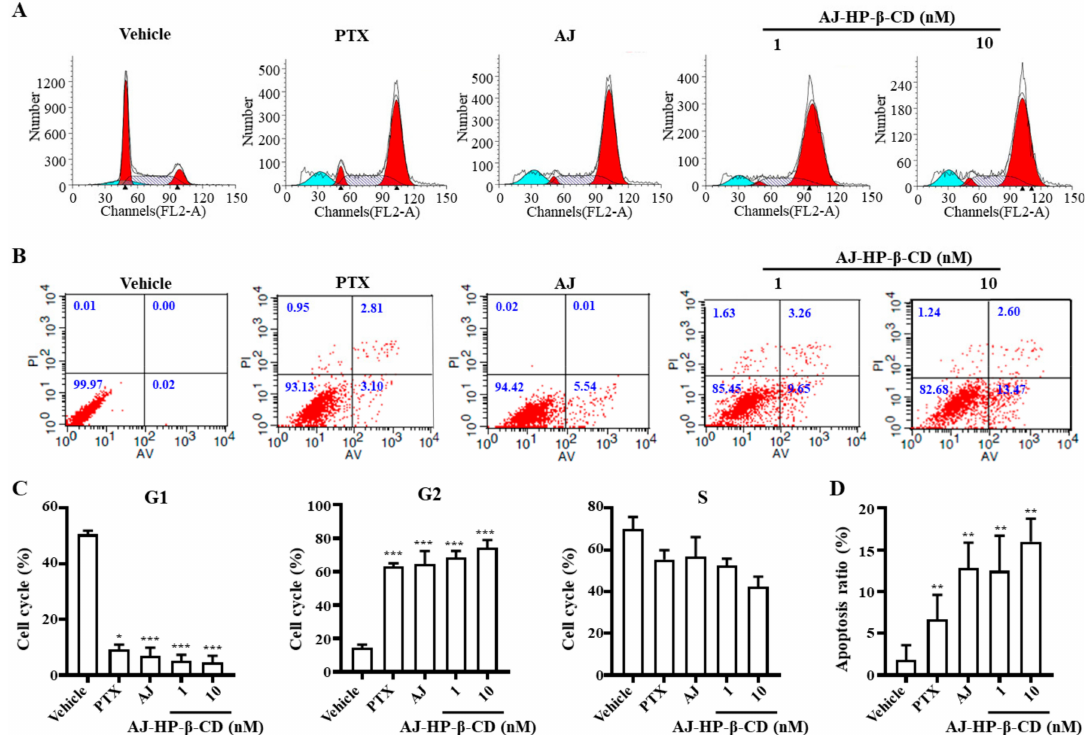
Figure 5. E ff ect of AJ-HP- β -CD on the cell cycle and apoptosis in 786-O cells. ( A ) 786-O cells were treated with PTX (10 nM), AJ (10 nM), and AJ-HP- β -CD (1, 3, 10 nM) for 12 h, and a flow cytometry analysis of the cell cycle assay was performed. ( B ) 786-O cells were treated with PTX (10 nM), AJ (10 nM), and AJ-HP- β -CD (1, 3, 10 nM) for 24 h. A flow cytometry analysis of apoptosis was performed in each group of cells. ( C ) The percentage of cells in G1, G2, S phases are shown in the histogram. ( D ) The percentage of apoptotic cells are quantitatively shown in the histogram, * p < 0.05, ** p < 0.01, *** p < 0.001 compared with vehicle ( n = 3), statistical analysis was calculated using student’s t -test ( n =